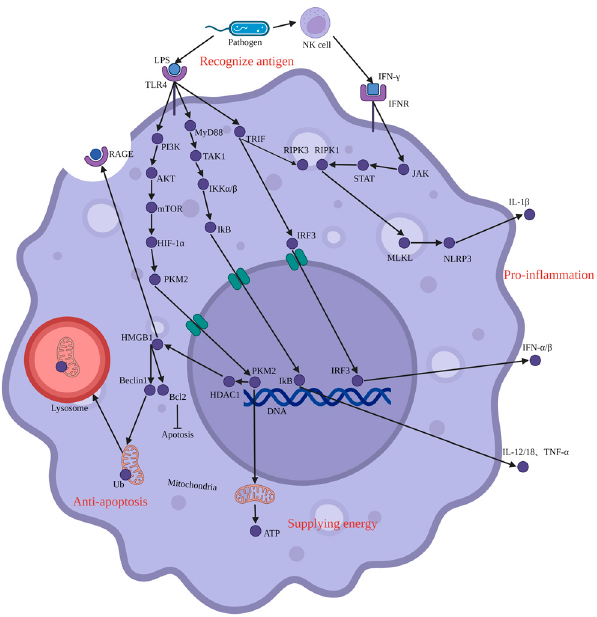
Figure 2. The signaling pathway of macrophages when releasing inflammatory factors. Macrophages recognize the lipopolysaccharide (LPS) of pathogens or the interferon (IFN)- γ released by natural killer (NK) cells. Macrophages produce interleukin (IL)-1 β , IL-12, IL-18, tumor necrosis factor alpha (TNF- α ), IFN- α / β and other pro-inflammatory factors through Janus kinase (JAK)-signal transducer of activators of transcription (STAT), toll-like receptors 4 (TLR4), nuclear factor kappa B (NF- κ B), interferon regulatory factor 3 (IRF3) and other pathways. At the same time, macrophages also undergo metabolic reprogramming. The increase of pyruvate kinase isozymes M2 (PKM2) in macrophages, on the one hand, can induce mitochondria to produce ATP to supply energy, on the other hand, it can lead to the increase of high mobility group box 1 protein (HGBM1) through histone deacetylase 1 (HDAC1), through the phosphatidylinositol 3-kinase (PI3K)-protein kinase B (PKB, also known as AKT)-mammalian target of rapamycin (mTOR) pathway. HGBM1 can phagocytize LPS through the receptor of advanced glycation end products (RAGE) on the surface of macrophages and lead to the dissociation of Beclin1 and Bcl2. Beclin1 can induce autophagy of damaged mitochondria through phosphatase and tensin homologue deleted on chromosome (PTEN) induced putative kinase 1 (PINK1)-Parkin, and Bcl2 can avoid the death of macrophages. The common role of both is to maintain the survival of